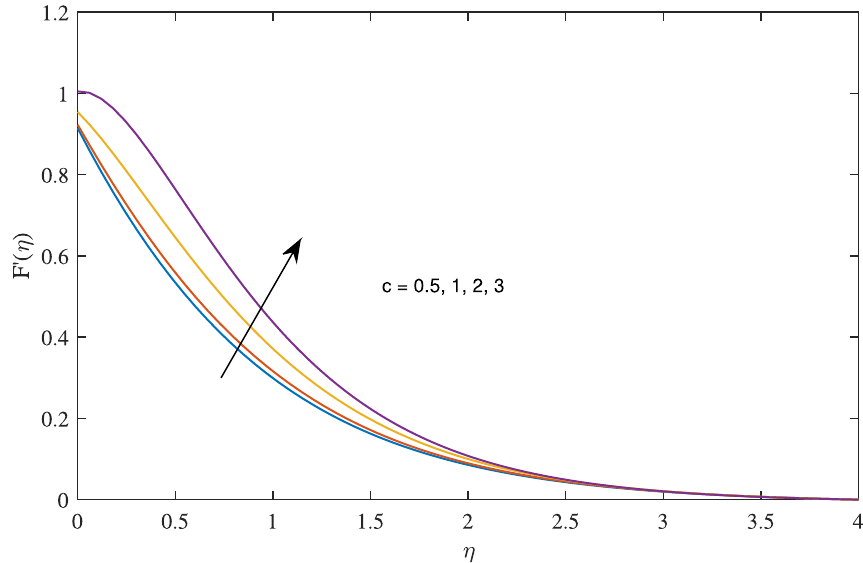
0.1 , β 0.1 and 0.5 , ζ 0.2 , N 1 , φ rd = = = = ◦ =